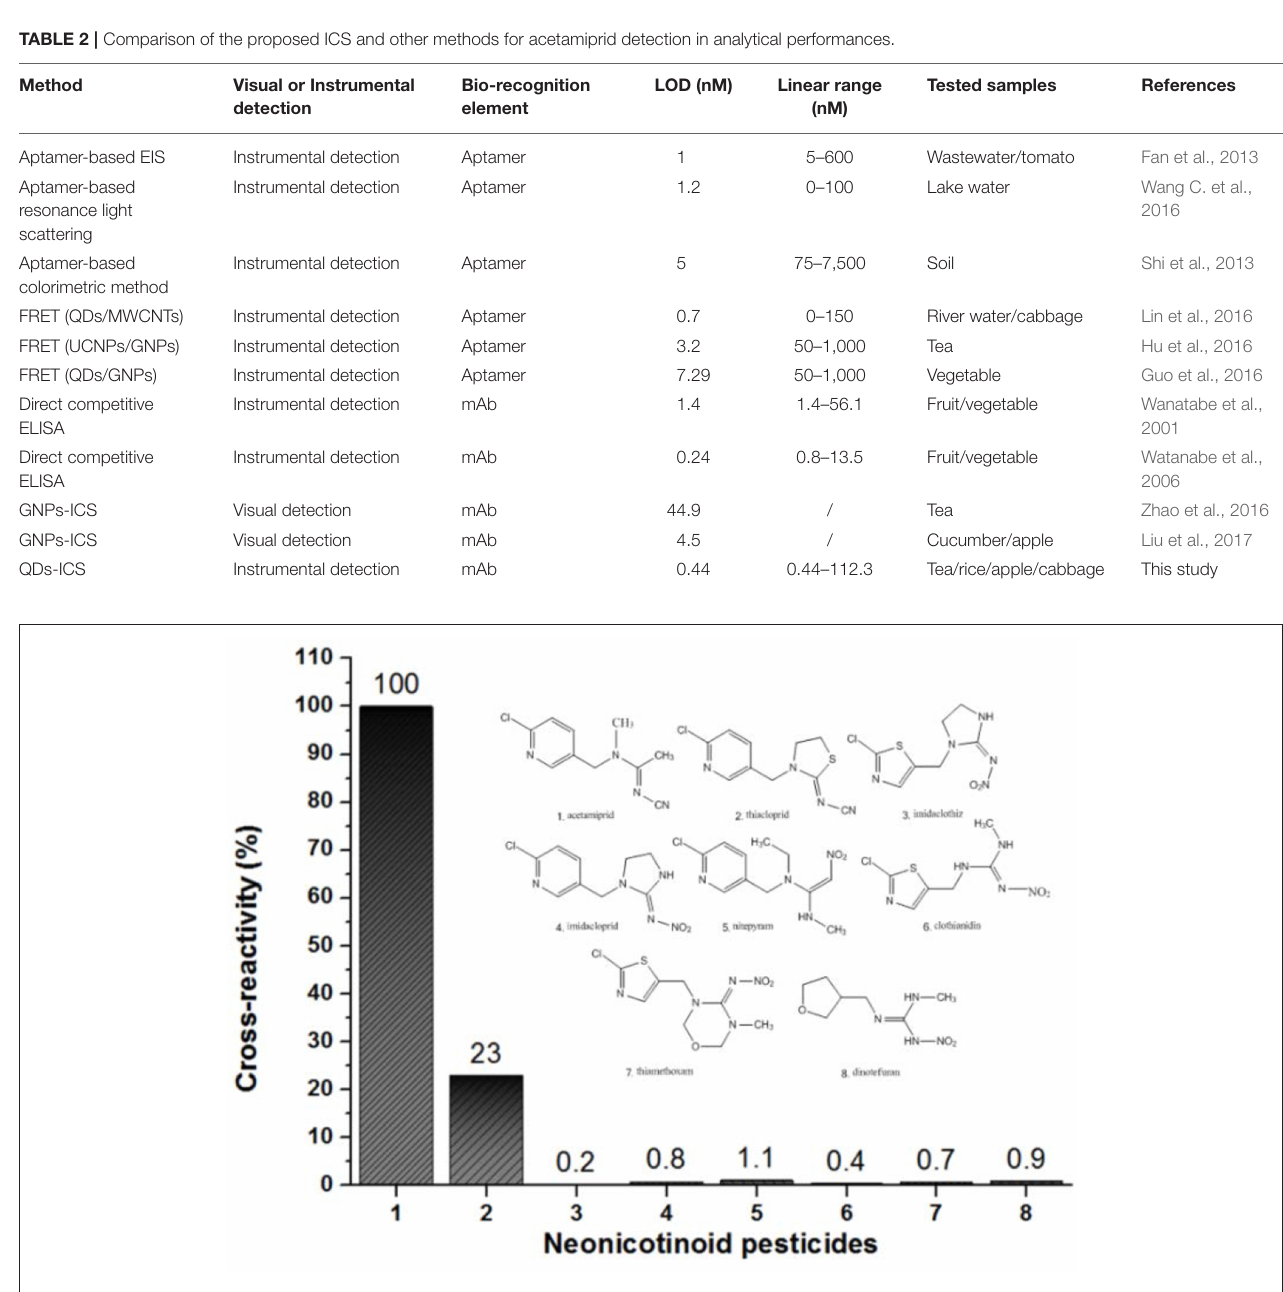
FIGURE 4 | Cross-reactivity of QDs-ICS for acetamiprid toward seven other neonicotinoid pesticides.